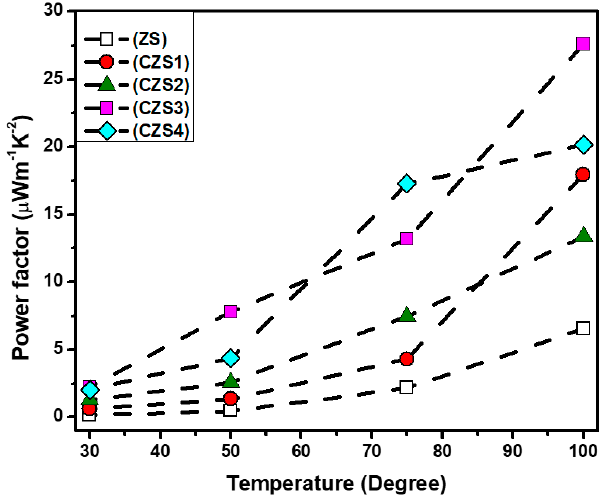
Figure 2. Calculated values of the power factor for the undoped and Cu-doped ZnSe samples, as a function of temperature.